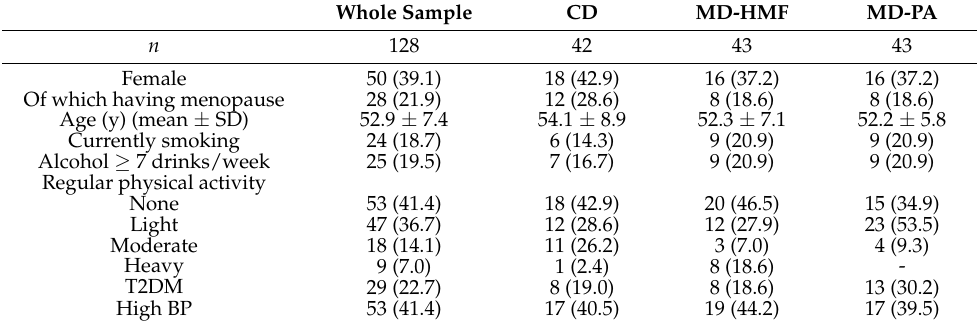
Table 1. Characteristics of the studied